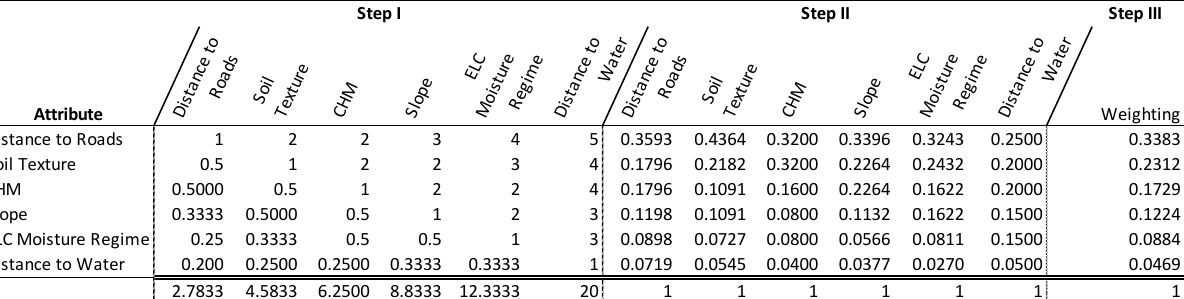
Table 1. Steps of AHP for determining weightings for attribute layers.